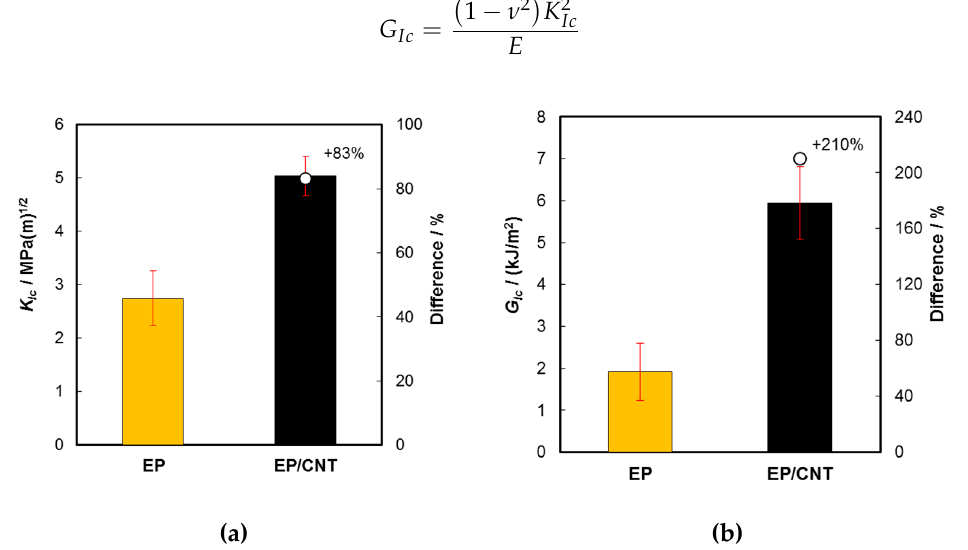
Figure 4. Results obtained from CT tests of neat epoxy (EP) and CNT/epoxy nanocomposites (EP/CNT): ( a ) fracture toughness ( K Ic ) and ( b ) critical strain energy release rate ( G Ic ).